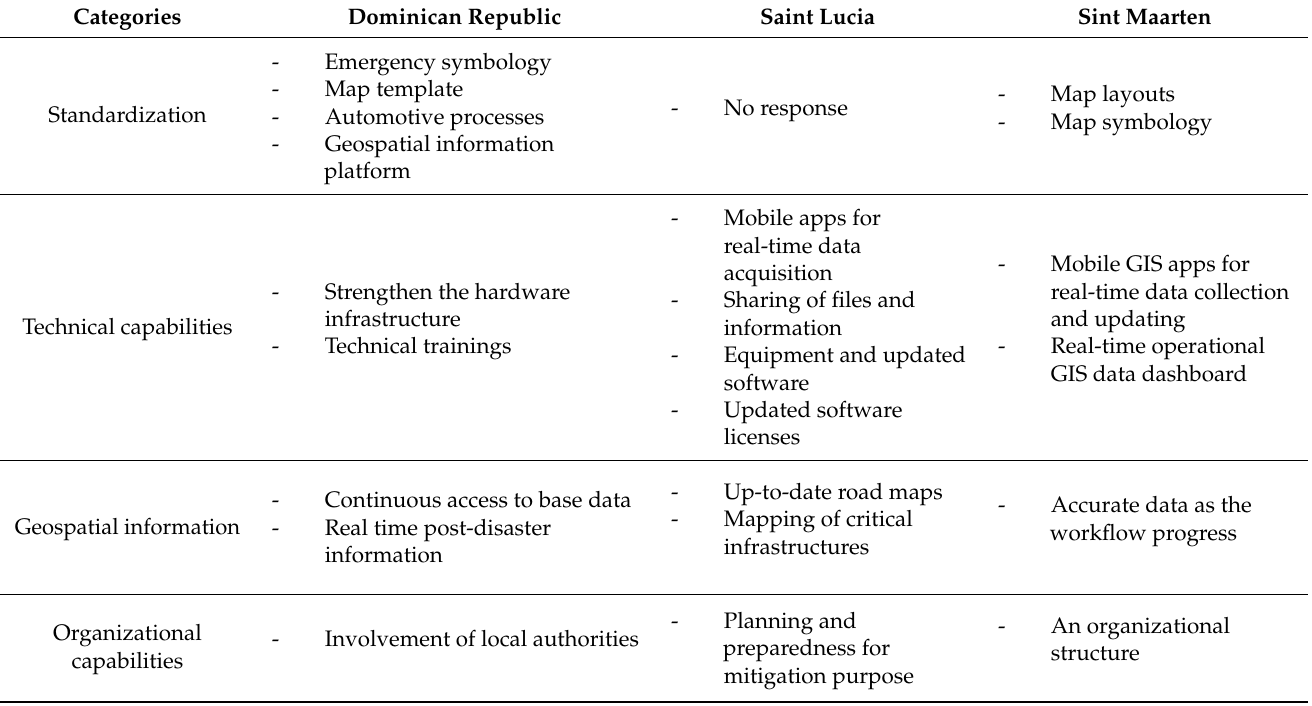
Table A4. Recommendations for EMT mapping and layout (Q33).